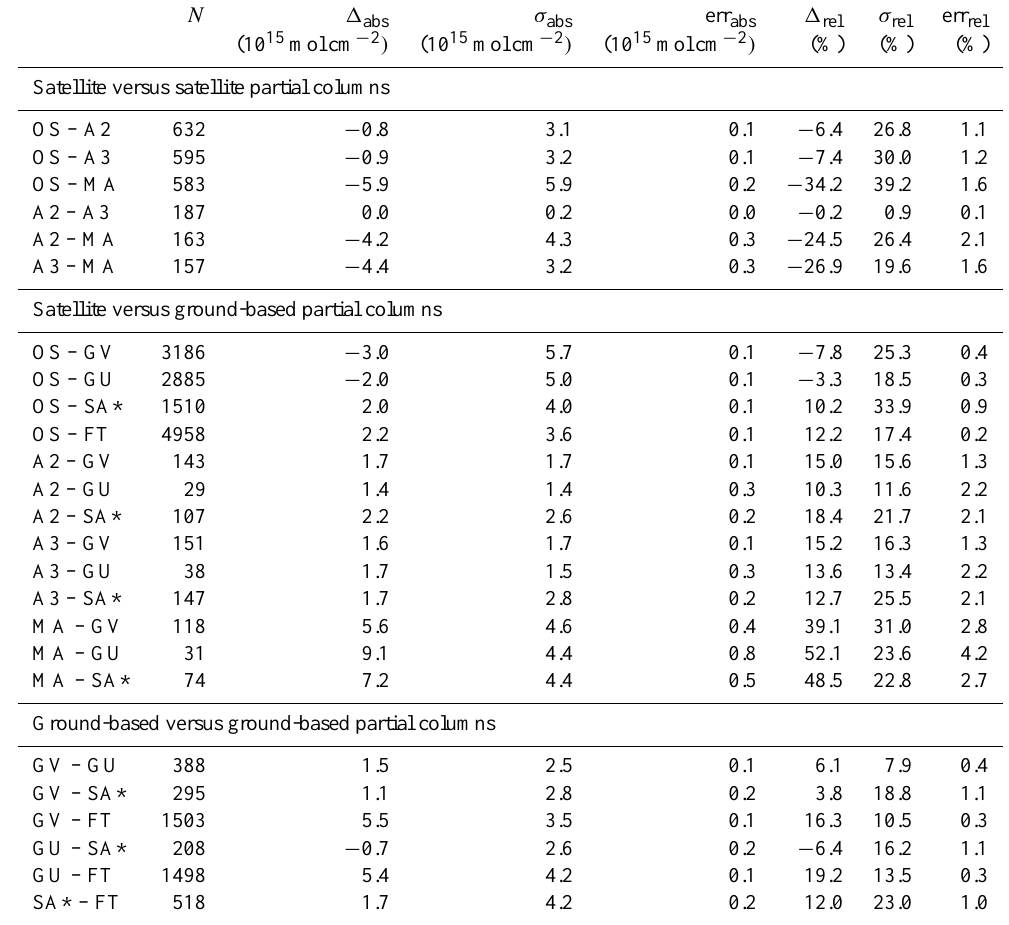
Table 4. As for Table 3, NO 2 partial columns. All measurements were scaled to local solar noon using the photochemical model. Instrument abbreviations are summarized in Table